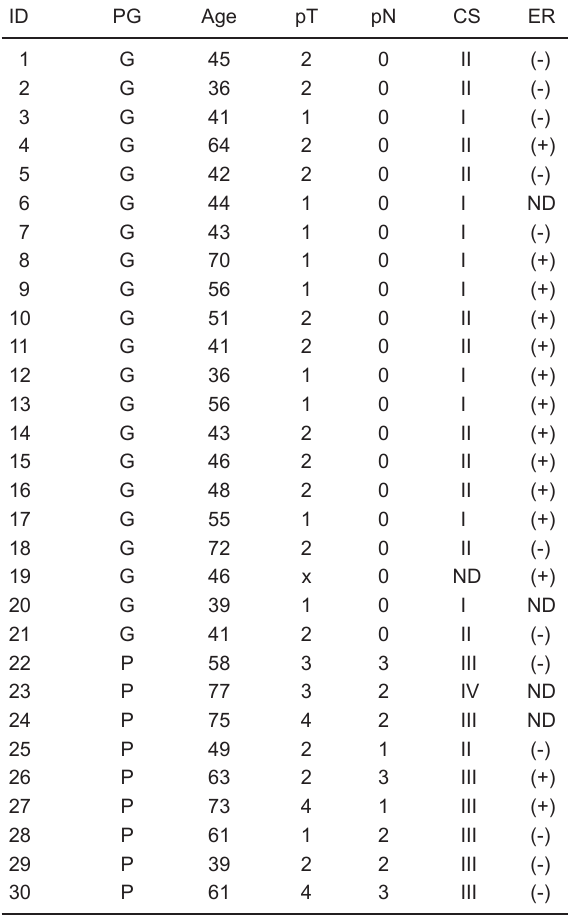
Table 2. Characteristics of breast carcinoma patients with a long- term follow-up (at least 5 years) who had paraffin-embedded tu - mor samples available for